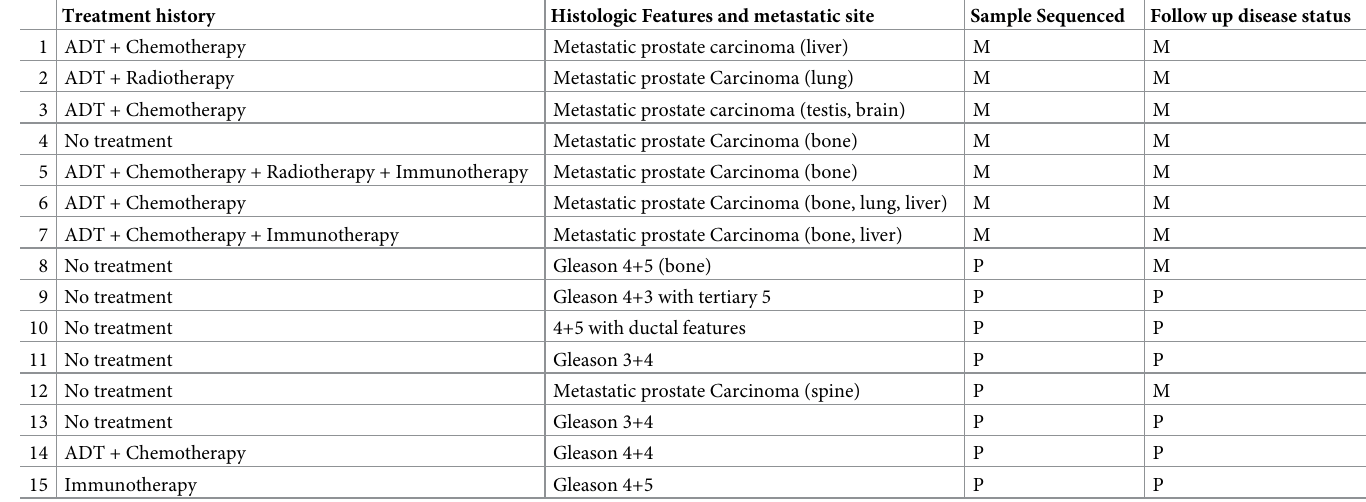
Table 3. Clinical features of TP53 wild type prostate carcinomas.